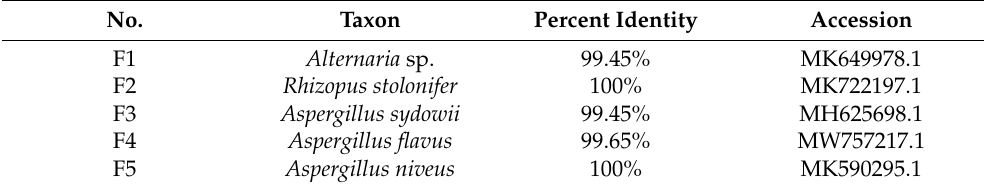
Figure 5. Characteristics of fungal colonies isolated from internally mildewed sunflower seeds. F1, Al- ternaria spp. F2, Rhizopus stolonifera . F3, Aspergillus sydowii . F4, Aspergillus flavus . F5, Aspergillus niveus . Table 1. Molecularly identified fungal species in the mildewed sunflower